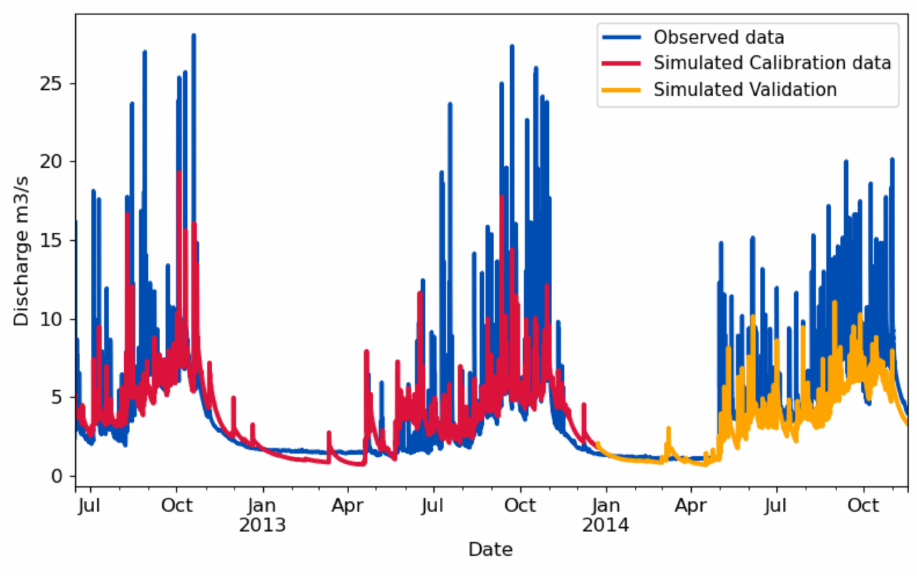
Figure 12. Flow hydrograph result from FW-2 4 km 2 . For the optimal set of parameters obtained by calibration for both SemiDist-1 and SemiDist-2 model, see Table 5. Table 5. Optimal set of parameters for Jiboa subcatchment for the SemiDist-1 and SemiDist-2 models.